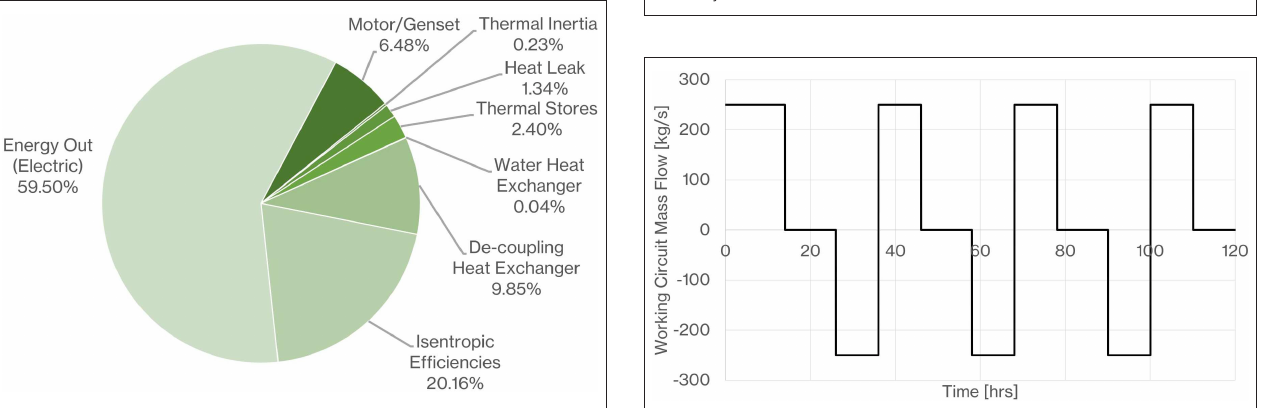
FIGURE 26 | Inventory of losses for each sub-system of the de-coupled 1 GWh PTES system.